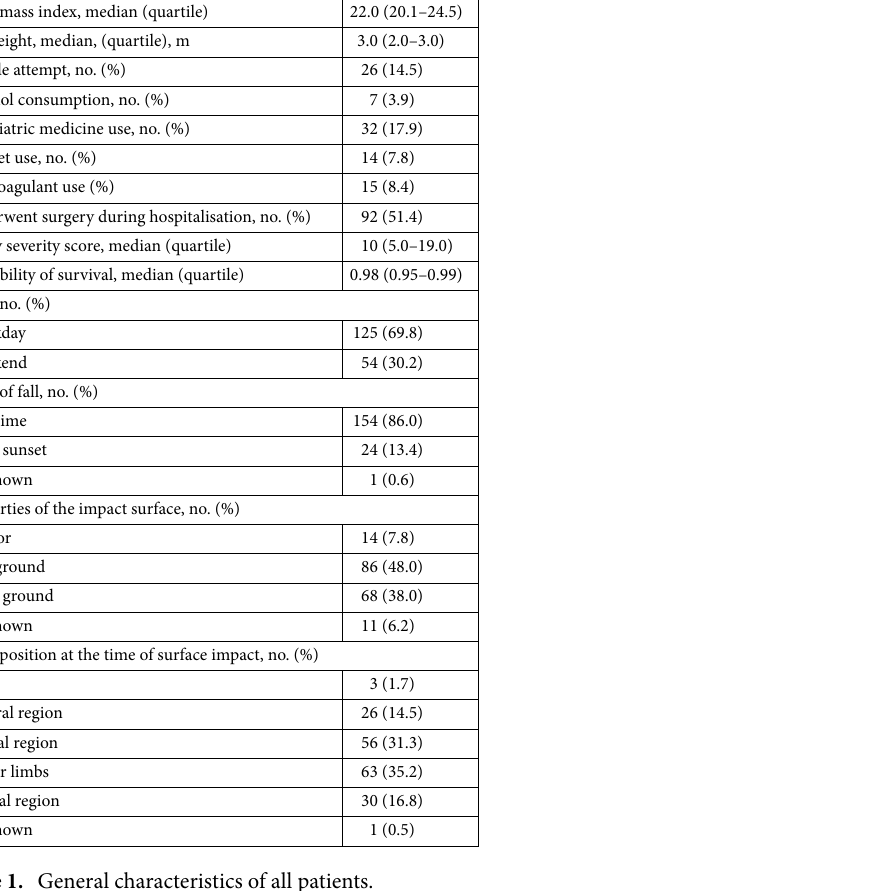
Table 1. General characteristics of all